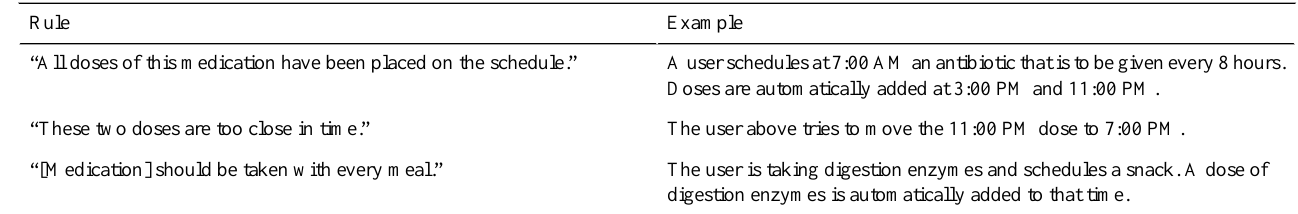
Table 3. Custom rules for automated